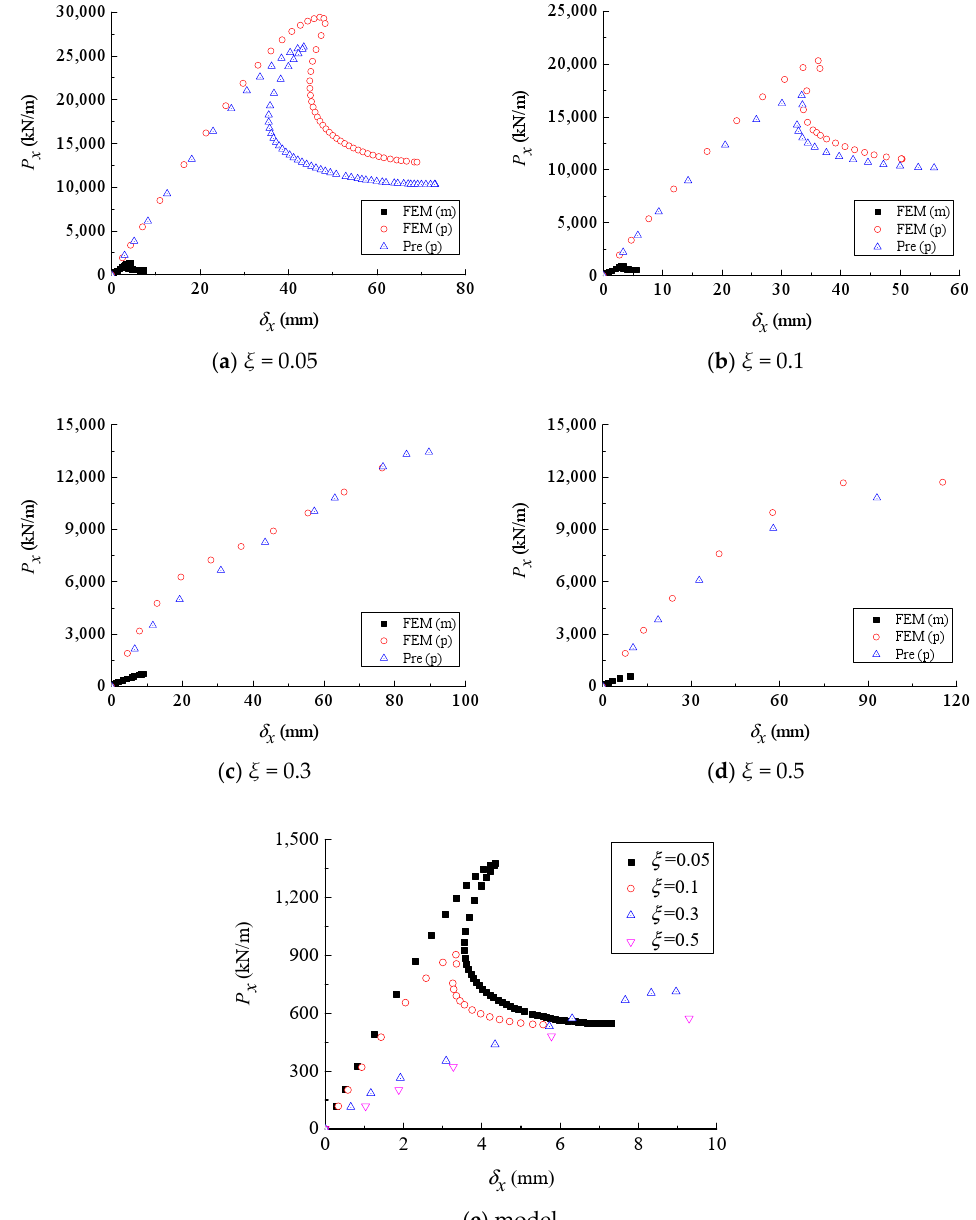
Figure 12. Comparison of the predicted and original load vs. end-shortening curves of the T-type stiffened cylinders with the SS3 boundary condition when the model material is brass. When the material of the model is PVC, Figure 14 shows the results of partial sim- ilarity and the equilibrium paths of the models for axial compression post-buckling of T-type stiffened cylinders with the SS3 boundary condition and four different geometric imperfections. As shown in Figure 14a–d, the equilibrium paths of the models can predict the results of its prototype using the scaling law Equation (18) and the deformation scaling factor. As observed from Figure 14e, the change rule of equilibrium paths of the models is similar to those of Figures 10e and 12e. The buckling mode shapes of the models are (1,3) at the limit point of the equilibrium path, and only the case of ξ = 0.05 is given, as